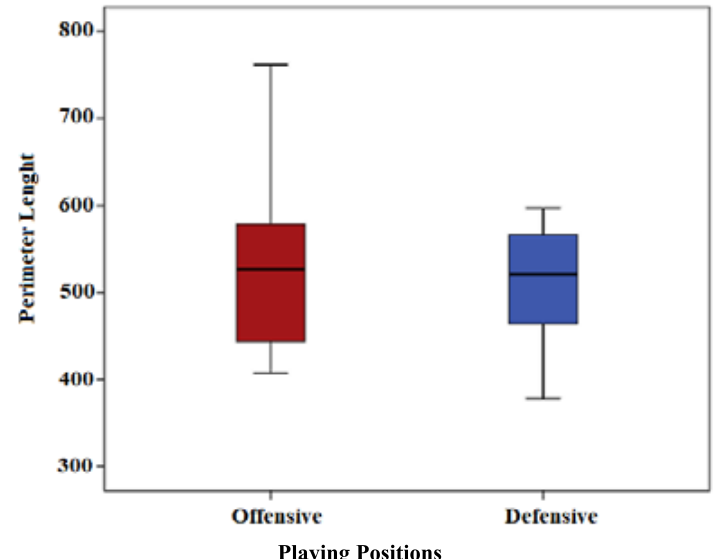
Playing Figure 7. Comparison of Perimeter Lenght ( o ) of players according to playing positions